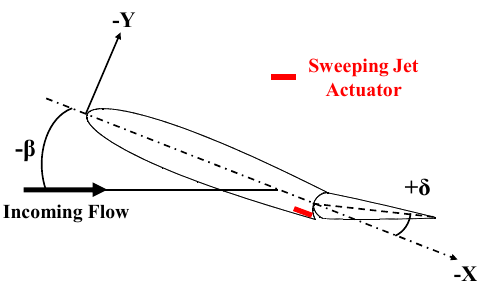
Figure 3. Definition of vertical tail model sideslip angle and rudder deflection angle.